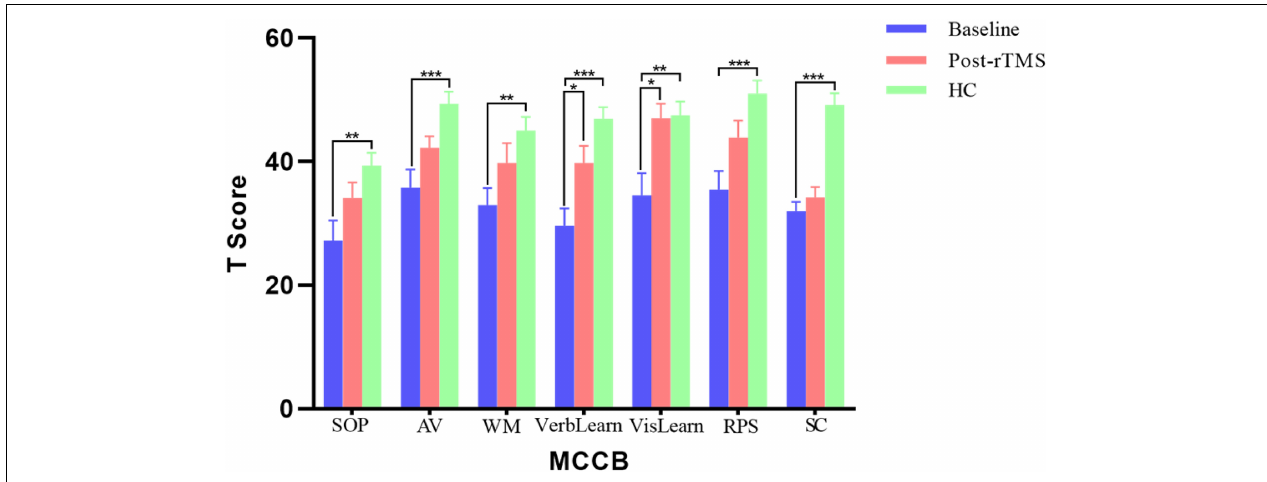
FIGURE 1 | The results of MATRICS consensus cognitive battery (MCCB) comparisons between patients (baseline and post treatment) and controls. * p < 0.05, ** p < 0.01, and *** p < 0.001.